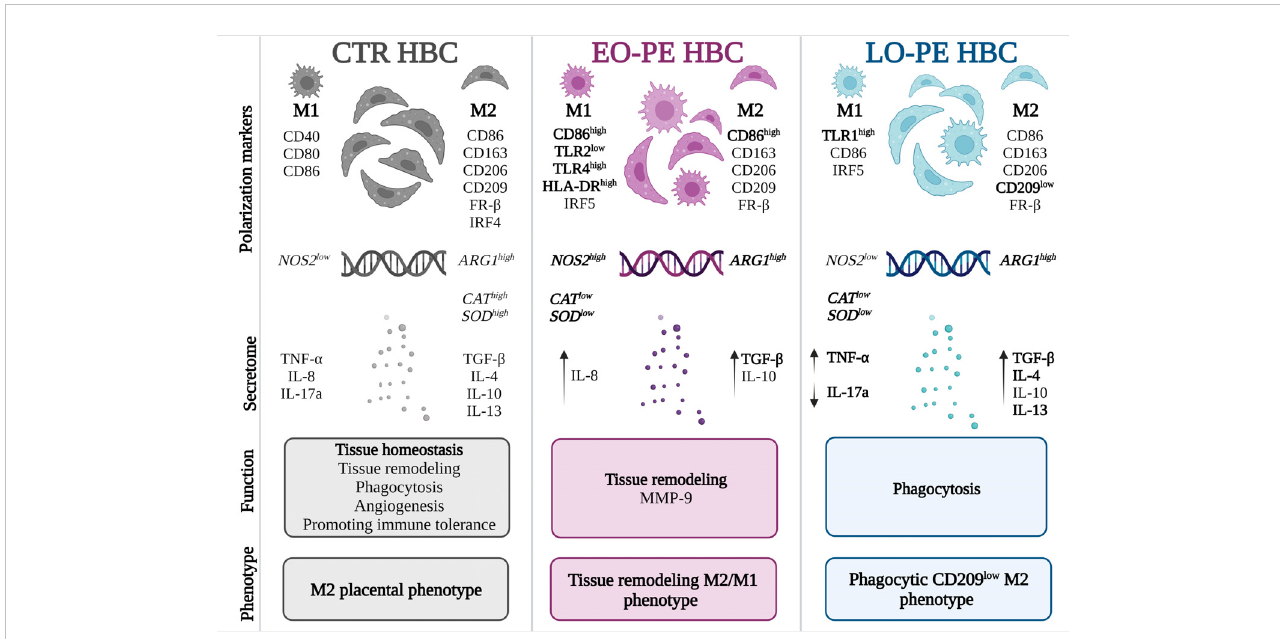
FIGURE 6 Different polarization patterns of CTR, EO - and LO-PE HBCs. HBCs isolated from CTR placenta develop a speci fi c placental phenotype and express both M1 and M2 polarization markers. In CTR placenta, their M2 nature is re fl ected by increased expression of ARG1 , CAT , and SOD , where HBCs promote tissue repair, angiogenesis, and homeostasis. Our results suggest that EO-PE HBCs develop an M2 phenotype that is strongly shifted toward M1 polarization. Their M2 phenotype is re fl ected in the upregulation of ARG1 , secretion of TGF- b , and tissue remodeling function, whereas features of M1 polarization are seen in the increased expression of TLR4, HLA-DR, IRF5, and NOS2 . In contrast, LO-PE HBCs tend to develop a phagocytic CD209 low M2 phenotype with increased production of IL-4, IL-13, and TGF- b . However, the higher expression of TLR1 and increased production of TNF- a indicate a speci fi c pro-in fl ammatory pattern that differs from the typical M2 polarization. The fi gure was generated using BioRender. Differences that were signi fi cant different between the groups studied are printed in